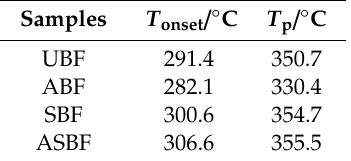
Table 4. Thermal degradation temperature of BF modified by various methods.